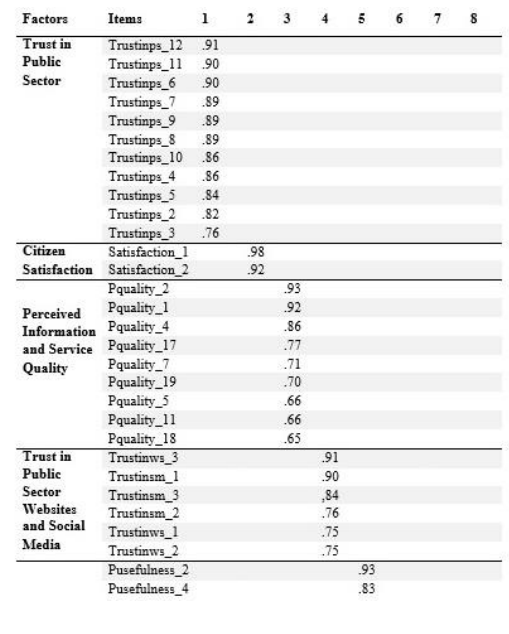
Table 1: The Results of the Exploratory Factor